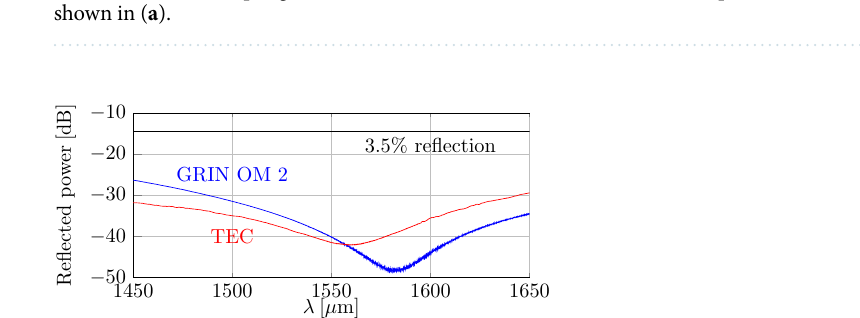
Figure 2. ( a ) Calculated MFD of OM1 (solid line) and OM2 (dashed line) type GRIN as a function of its length. ( b ) Coupling loss between Gaussian mode with MFD of 24.1 µ m and output of GRIN mode field adapter shown in ( a ). ( c ) Coupling loss between NANF fundamental mode and output of GRIN mode field adapter shown in ( a ).